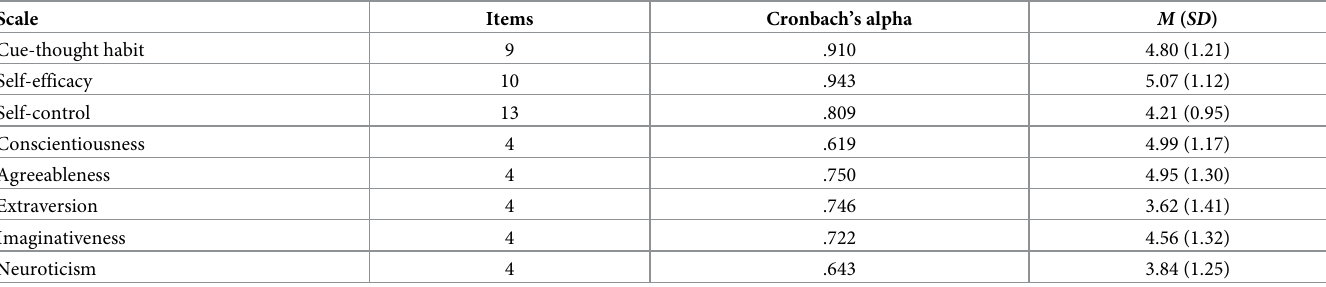
Table 1. Internal consistency and descriptive statistics of the used questionnaires.